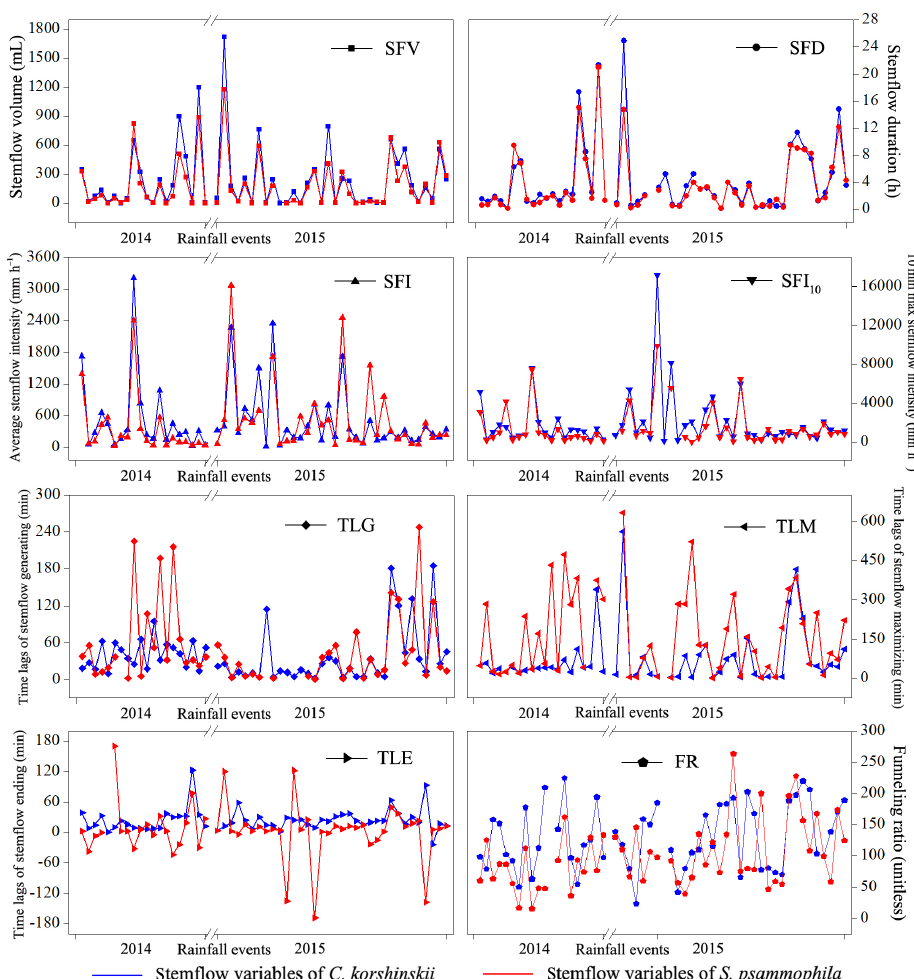
Figure 3. Inter-event variations in stemflow variables of C. korshinskii and S. psammophila during the experimental